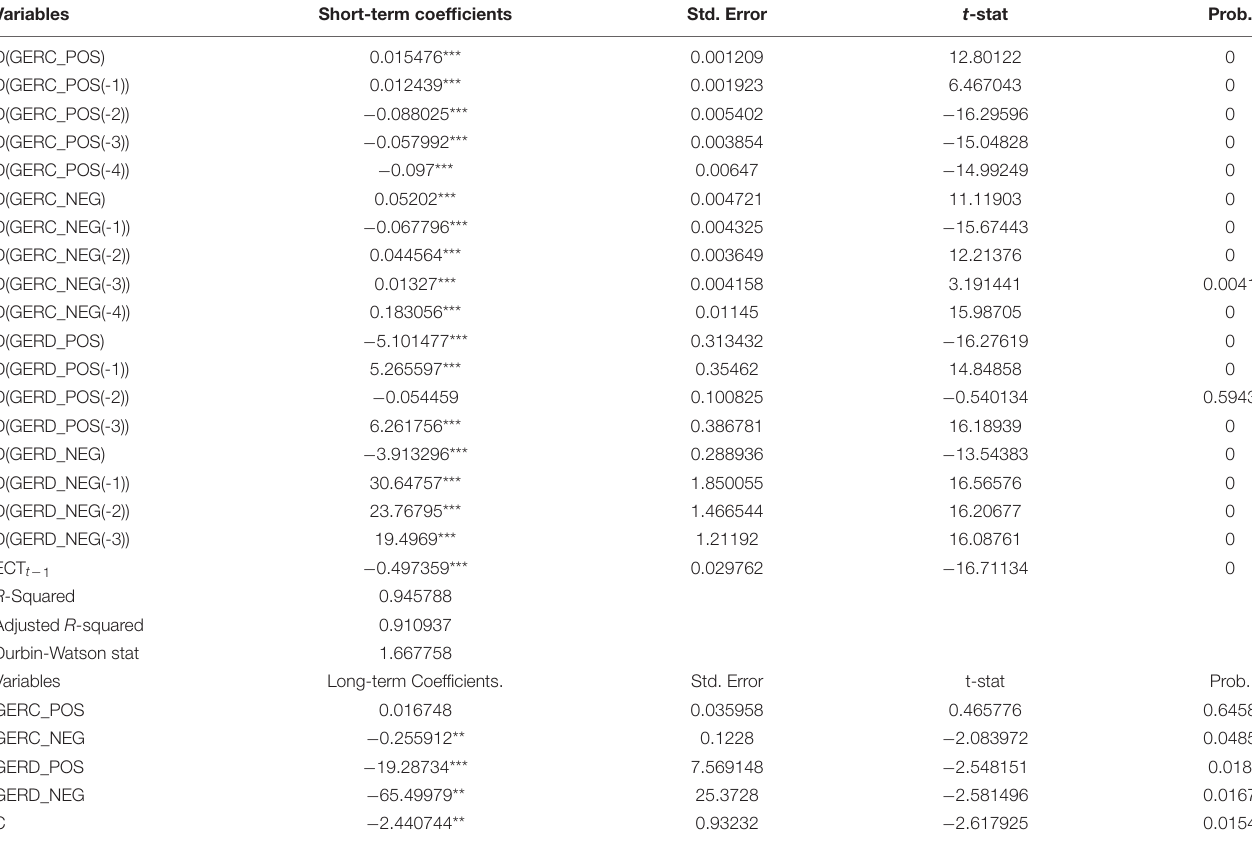
TABLE 9 | Asymmetric parameters of DAXR.